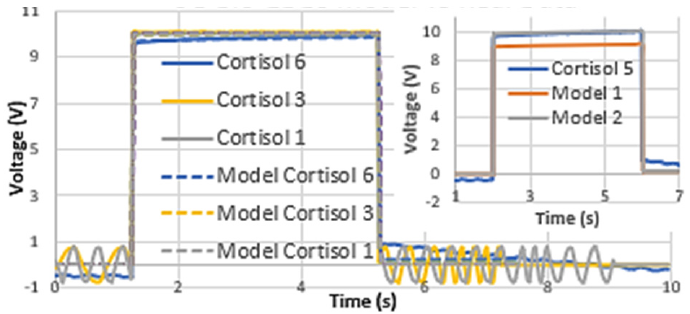
Figure 6. Comparison of real OEGFET equivalent data to equivalent circuit model 2 for all cortisol dilutions. Inset: Comparison of model 1 and model 2 to cortisol dilution 5.